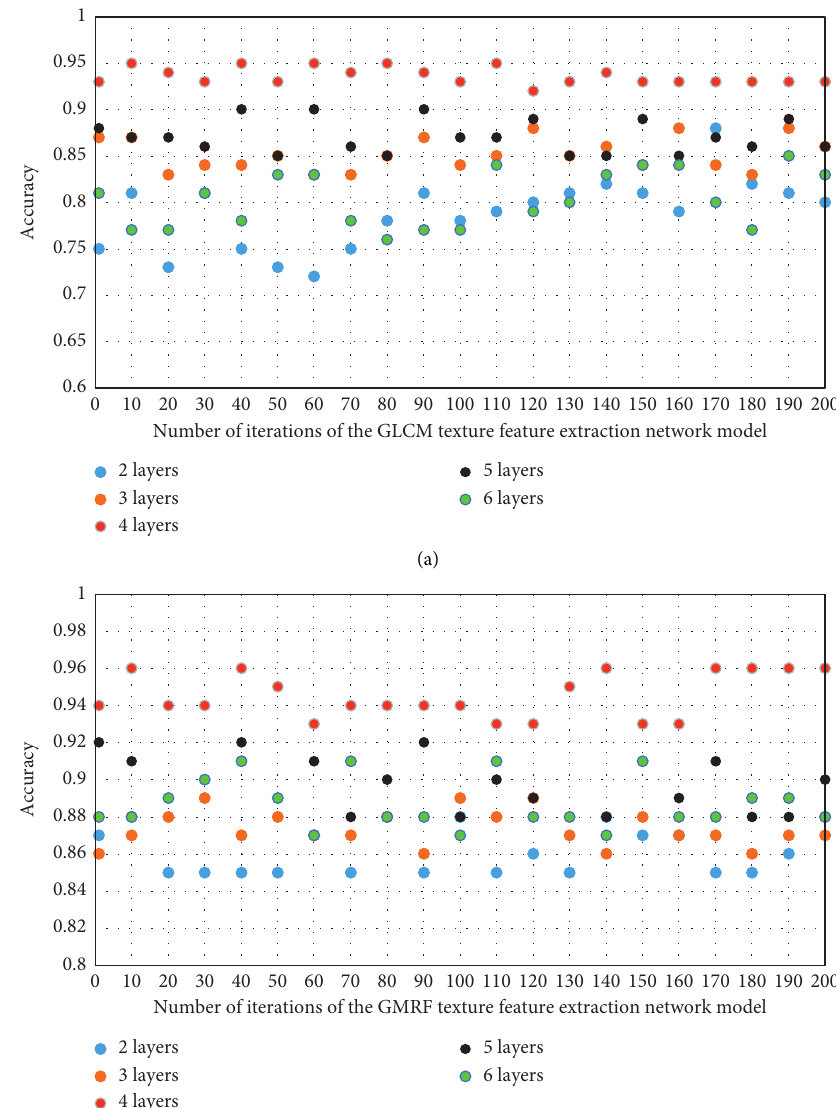
Figure 4: Experimental results with different numbers of hidden